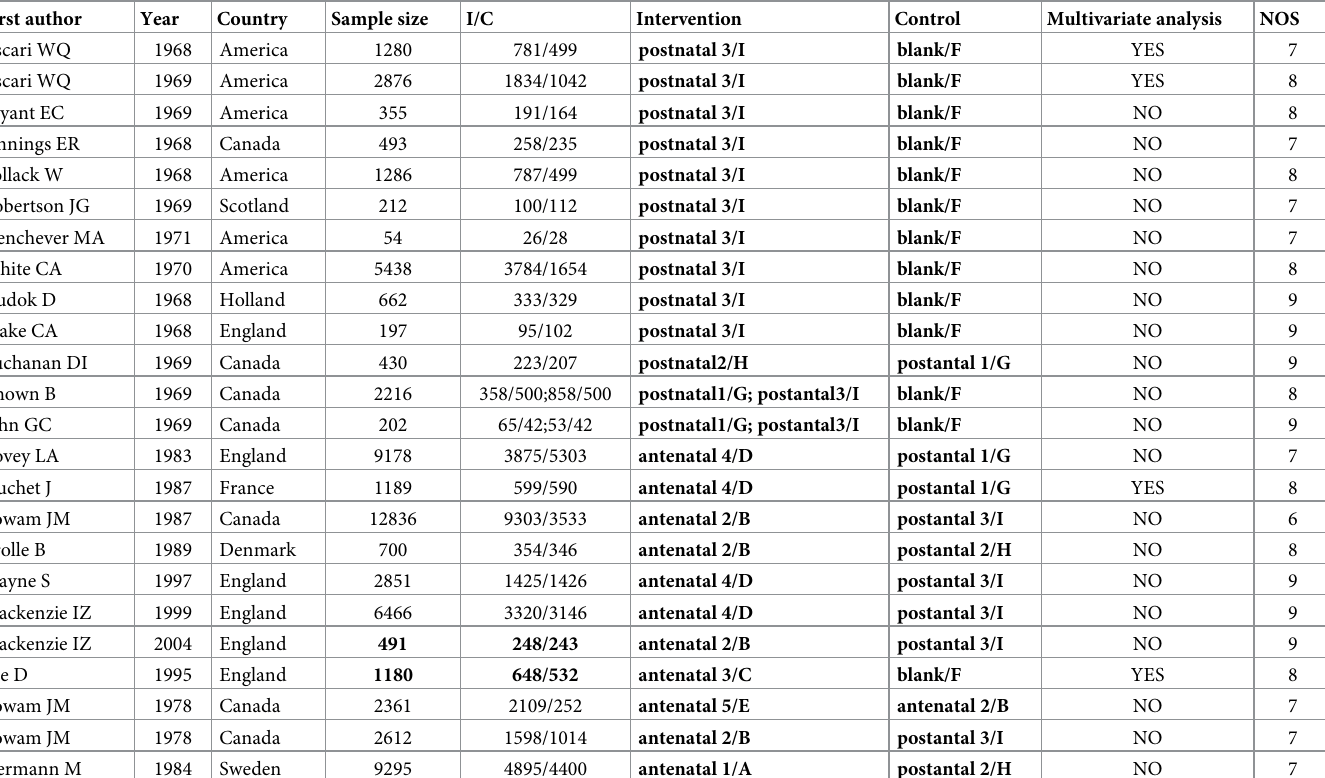
Table 1. Main characteristics of all included studies.